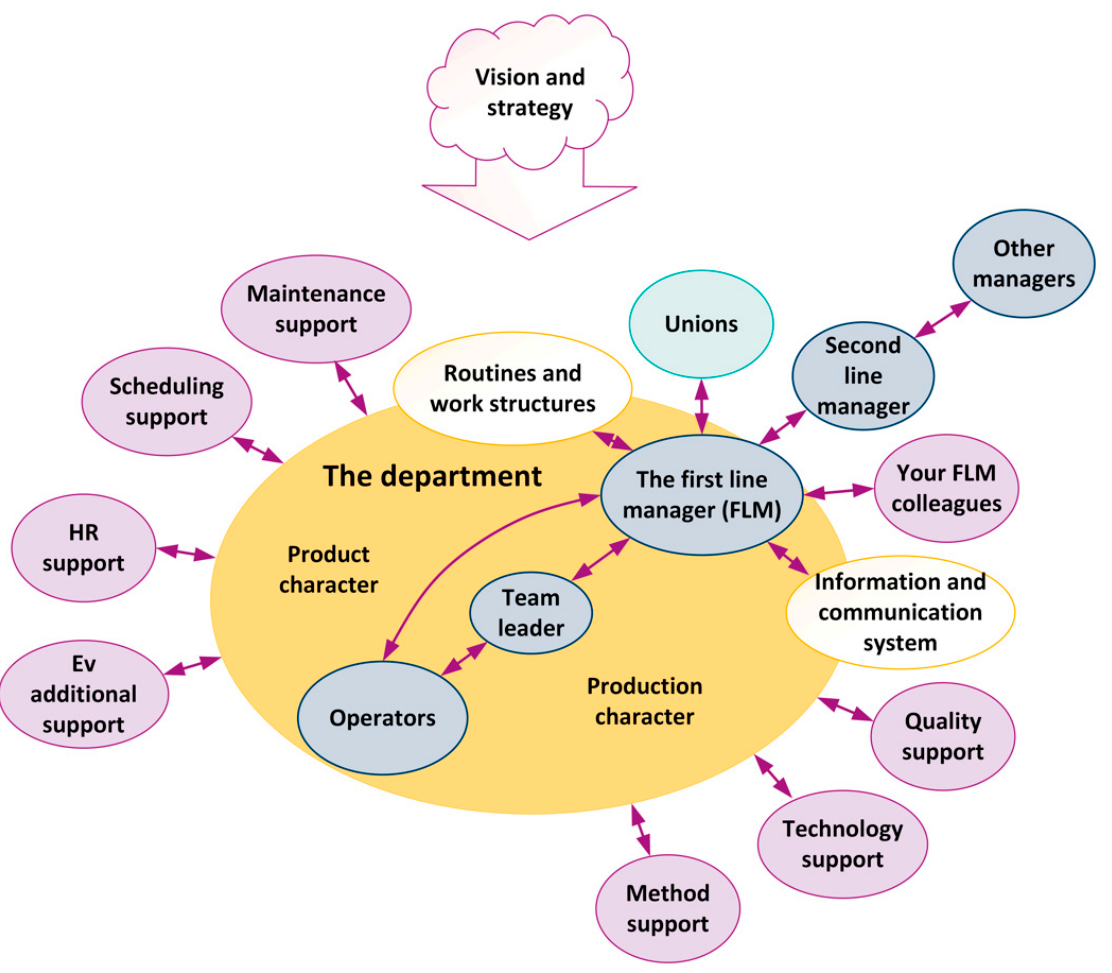
Figure 2. The ecosystem of the first line manager (a case of decentralized proactive change manage- ment) (source: Karltun et al. [11]).